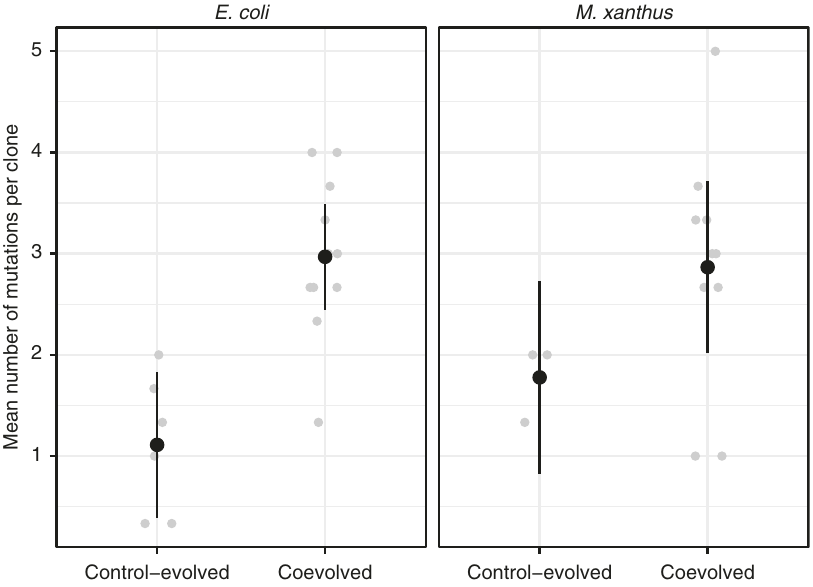
Fig. 4 Predator – prey coevolution accelerates genome evolution. Signi fi cantly more mutations were present among clones from coevolved prey and predator populations than in control populations ( n = 3 clones for each species for most individual populations, total n = 33 and n = 18 for coevolved and control-evolved prey populations, respectively; n = 31 and n = 8 for coevolved and casitone-evolved predator populations, respectively). Mutator clones (three clones from one coevolved prey population and fi ve clones from two coevolved predator populations) were excluded. Gray dots are the means across the included clones for each population, black dots are treatment means and error bars represent 95% con fi dence intervals ( t -distribution) of treatment means. Source data are provided as a Source Data fi High frequencies of mutator clones with elevated numbers of casitone (one-sided t test: t 11 = 2.49, p = 0.015, Fig. 4). mutations were found in three of the twelve coevolved Predator – prey interactions may be responsible for this effect, but communities, once on the prey side and twice on the predator due to supplementation of media with casitone rather than glu- side. The three E. coli clones sampled from ME1 carry 15 – 23 cose in this treatment (to allow predator survival) the possibility mutations per clone and share a mutation in the mismatch repair of differential abiotic carbon-source effects on predator genome gene mutL (Supplementary Table 5). The three M. xanthus clones evolution cannot be excluded.